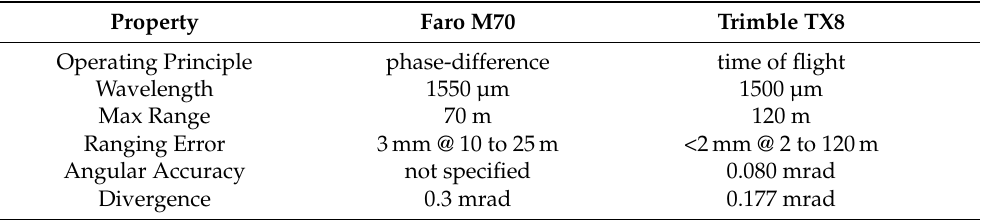
Table 1. Specification of the TLS (FARO M70 and Trimble TX8) used to capture point cloud informa- tion in this study.